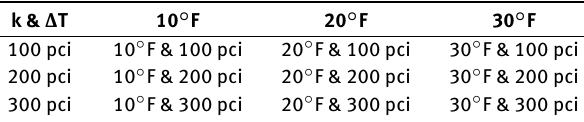
Table 1: Combinations for KENPAVE Analysis